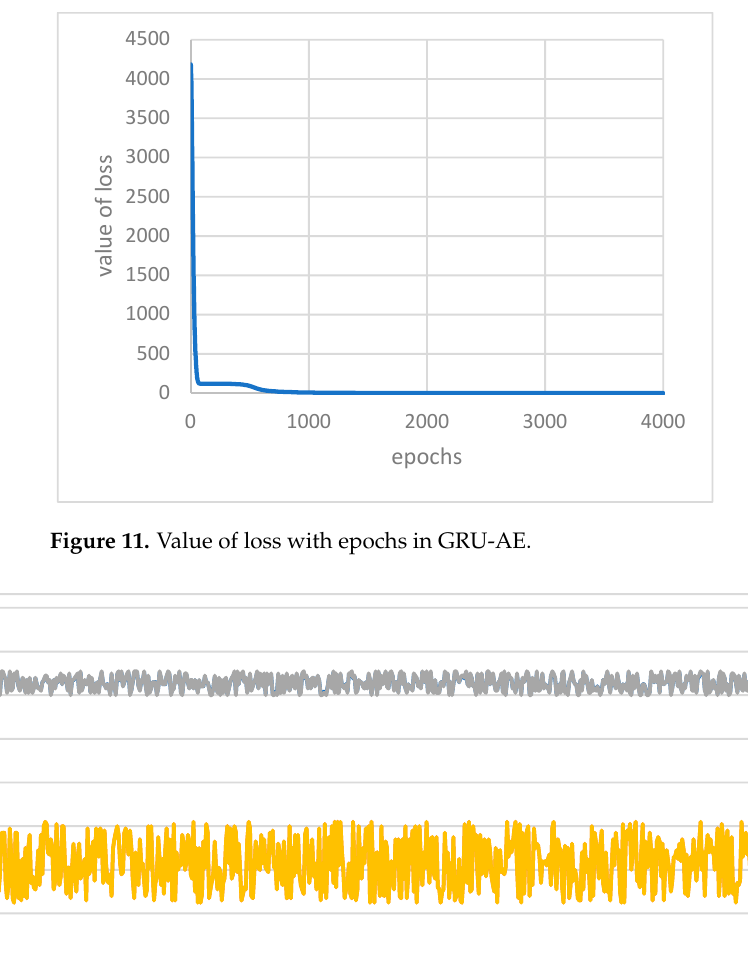
Figure 13. Comparison of input and output of AutoEncoder model in test set 2.